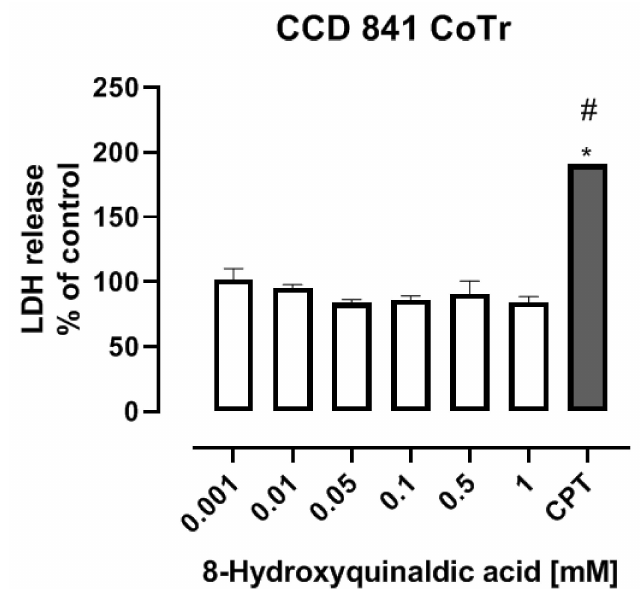
Figure 1. The e ff ect of 8-hydroxyquinaldic acid on viability of human colon epithelial CCD 841 CoTr cells. CCD 841 CoTr cells were exposed to culture medium supplemented with 2% fetal bovine serum (FBS) (control) or serial dilutions of 8-hydroxyquinaldic acid (0.001; 0.01; 0.05; 0.1; 0.5; 1 mM) in culture medium supplemented with 2% FBS for 24 h. The toxicity of 8-hydroxyquinaldic acid was assessed by the LDH method. Data represent a mean value (% of control) ± SEM from six independent experiments (the mean value of control = 100%). # : positive control, 25 µ Mcamptothecin(CPT)—the cytotoxic e ff ect of CPT on CCD 841 CoTr cells was previously reported by Czerwonka et al. (2020) [16]. Values significant (*) in comparison to the control at p < 0.05 (one-way ANOVA with post hoc Tukey